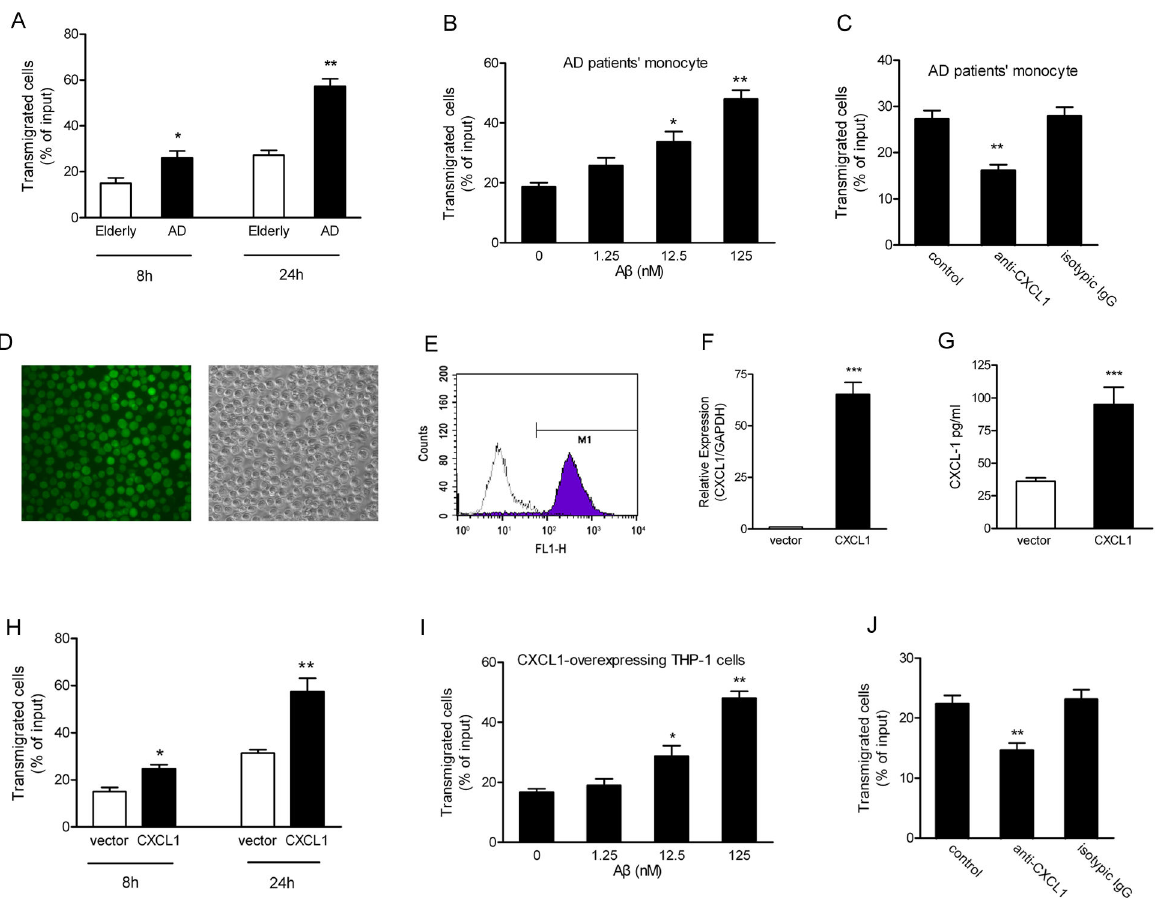
Figure 2. AD patient’s monocytes or CXCL1-overexpressing THP-1 cells had an enhanced ability to cross HBMEC monolayer in response to Aβ. (A) 125nM Aβ were added to the lower chamber of the Transwell insert cultured with HBMEC, AD patients’ monocytes were loaded on upper chamber of the Transwell insert and incubated for 8h or 24h. The cells transmigrated into the lower chamber were harvested and counted. Data were the mean±S.D. * p < 0.05, ** p < 0.01 as compared with age-matched elderly controls (n=8); (B) Transendothelial migration assays were performed in the presence of Aβ in 0, 1.25, 12.5, and 125nM respectively in the lower chamber of the Transwell insert cultured with HBMEC. Monocytes derived from AD patients were added to the upper chamber of Transwell insert for 24h. Transmigrated cells were harvested and counted. The results represent three independent experiments. Data were the mean±S.D. * p < 0.05, ** p < 0.01; (C) AD patients’ monocytes with anti-CXCL1 neutralizing antibody were loaded into the upper chamber. The cells transmigrated into the lower chamber were counted after 24h. Data were mean±S.D. ** p < 0.01. (D) THP-1 cells was transduced by lentivirus based vectors and efficiently expressed GFP. (E) 1×10 6 transduced THP-1 cells were analyzed by flow cytometry and GFP fluorescence intensity was measured on the FL1 channel. Approximately 97% of the THP-1 cells were GFP-positive. Real-time RT-PCR (F) or ELISA (G) was done to detect the expression of CXCL1 in THP-1 cells transduced with lentivirus based CXCL1. (H) Transendothelial migration assays were performed in the presence of Aβ in 125nM in the lower chamber of the Transwell insert cultured with HBMEC. CXCL1-overexpressing THP-1 cells were added to the upper chamber of Transwell insert for 8h or 24h. (I) In the presence of Aβ in 0, 1.25, 12.5, and 125nM respectively in the lower chamber of the Transwell insert cultured with HBMEC, CXCL1-overexpressing THP-1 cells was added to the upper chamber of Transwell insert for 24h. (J) CXCL1-overexpressing THP-1 cells with anti-CXCL1 neutralizing antibody were loaded into the upper chamber in the presence of Aβ in 125nM in the lower chamber of the Transwell insert cultured with HBMEC. The cells transmigrated into the lower chamber were counted after 24h. Transmigrated cells were harvested and counted. The results represented three independent experiments. Data was the mean±S.D. * p < 0.05, ** p < 0.01.